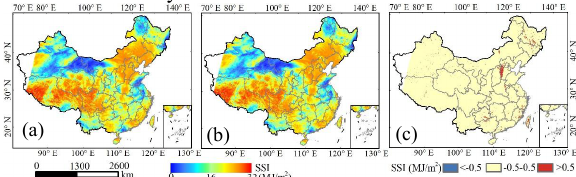
Figure 10 . Spatial distributions of the estimated daily global SSI from the Himawari-8 hourly and 10-minute radiation products on August 21, 2016, as well as a map of the corresponding differences: (a) estimation from hourly products, (b) estimation from 10-minute products, and (c) the difference in the daily global SSI estimated from the hourly and 10-minute radiation